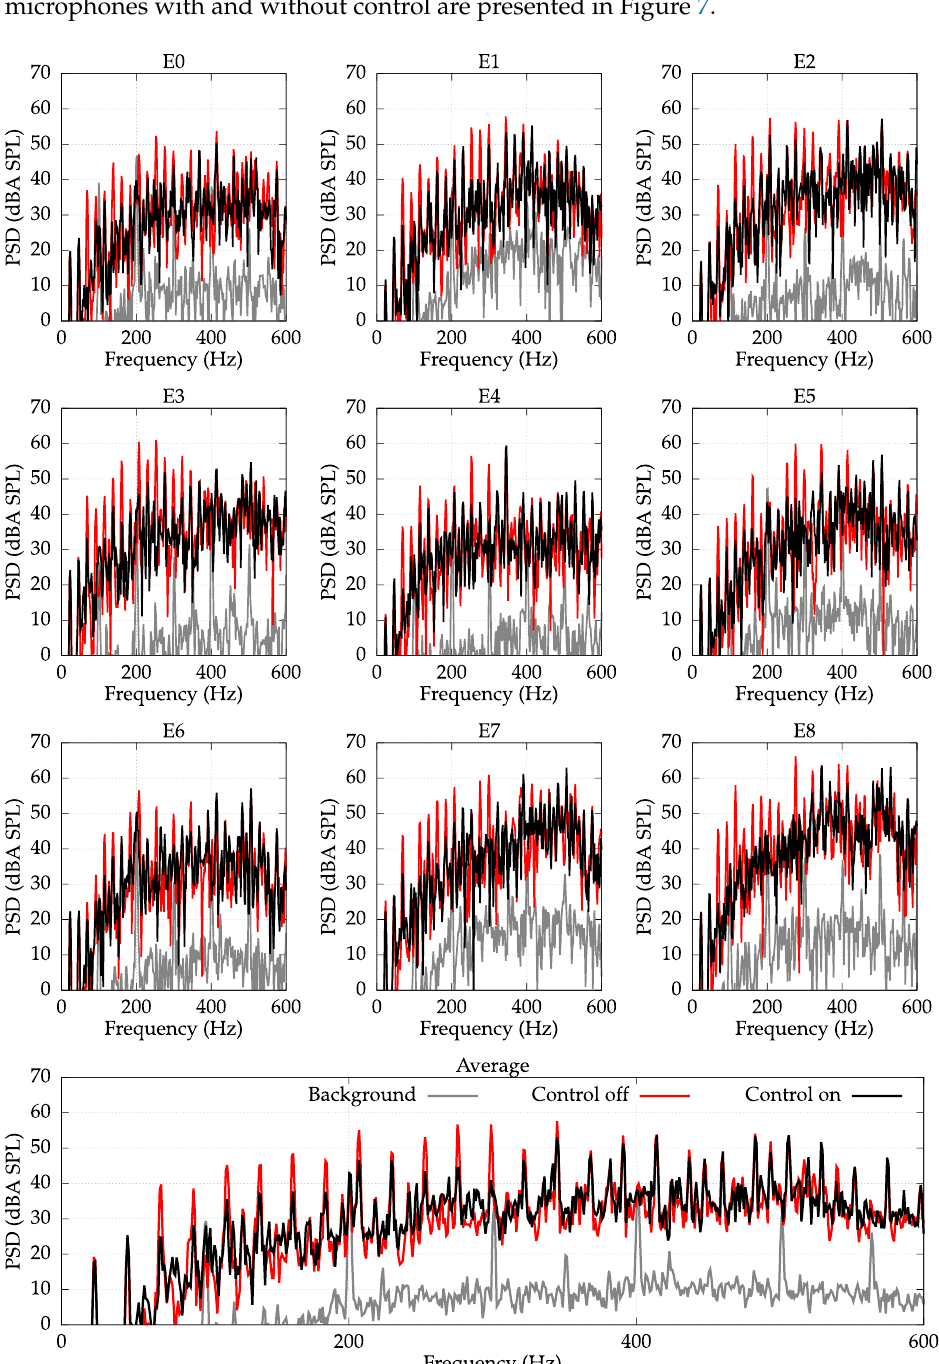
Figure 7. PSD with an A-weighting measured at error microphones E0–E8. Unbalanced load of 500 g. Spin velocity 1340 RPM. Average reduction: 4